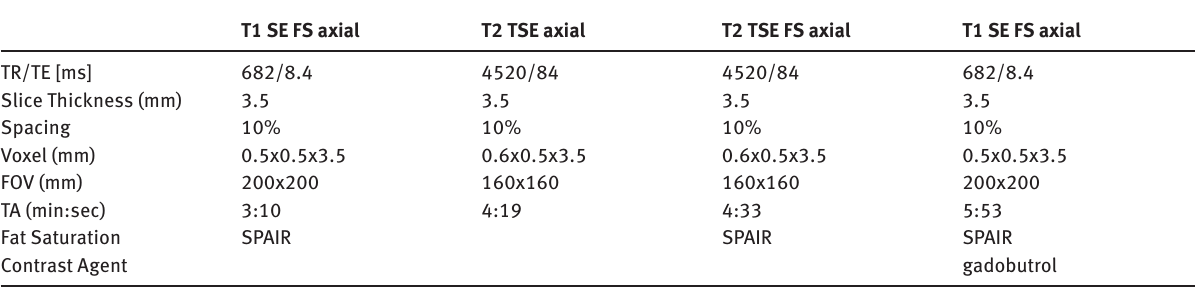
Table 1: MRI imaging